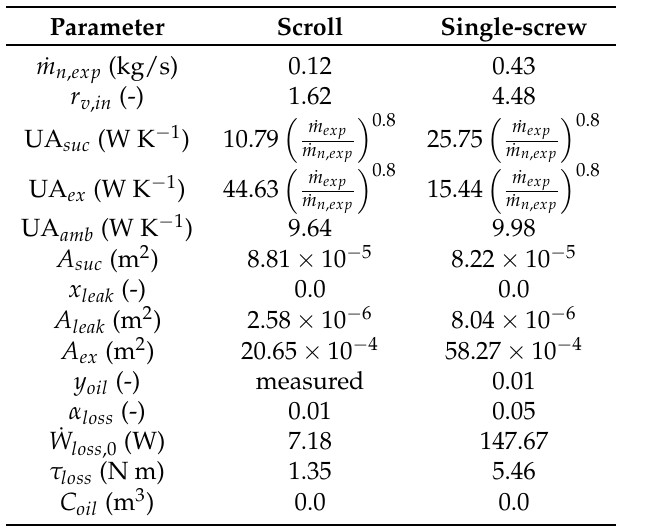
Table 5. Identified parameters of the expander semi-empirical model for scroll and single-screw